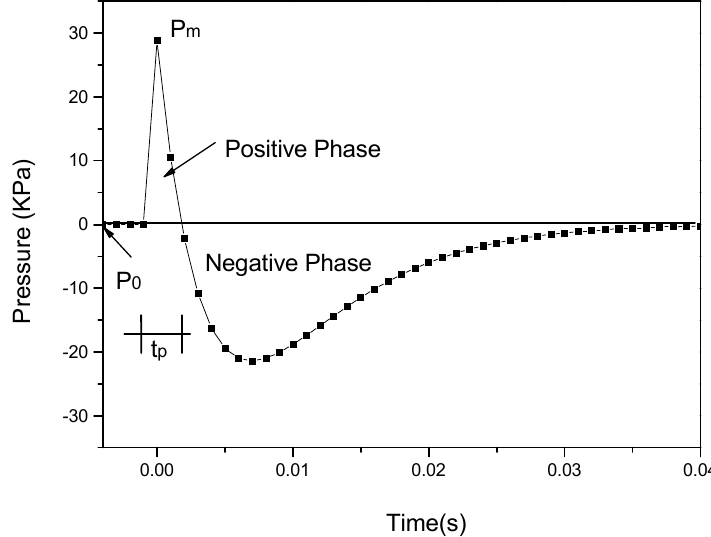
Figure 2. Variations of blast loading according to time